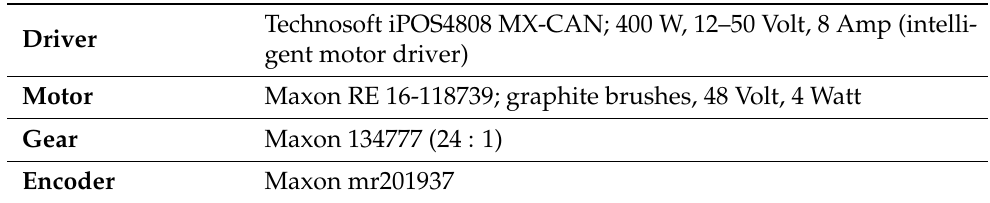
Table 1. Platform hardware